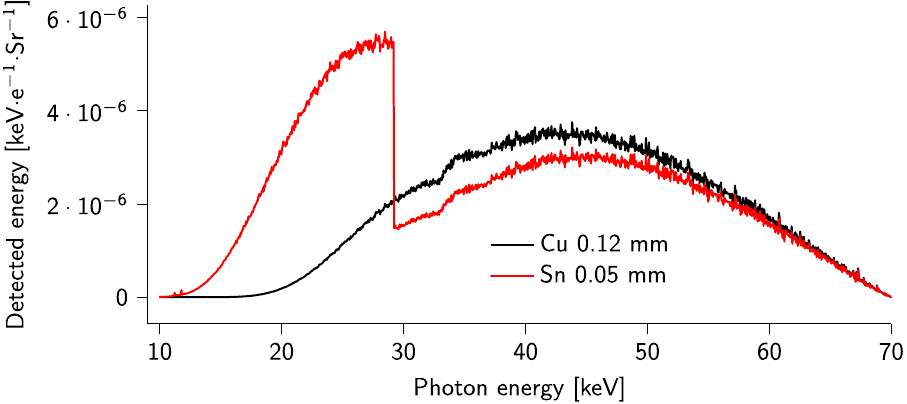
Figure 6. Detected energy for the specific tube-detector combination used at Nanowood, modulated by the theoretical elemental absorption profiles of the Cu and Sn filters used in this study. The difference between these two curves gives an insight on the energy ranges that would be highlighted by this particular DECT